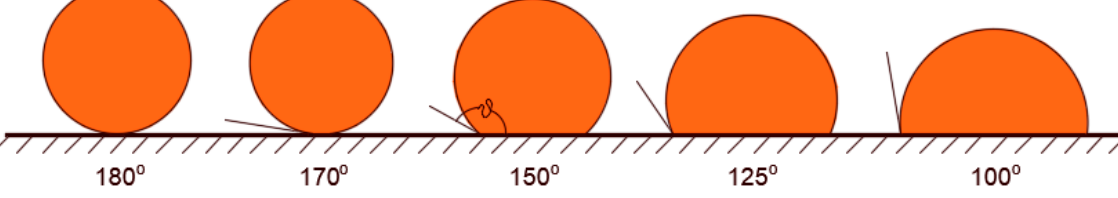
Figure 6. Succession of configurations of oil droplets at the surface of a membrane with different contact angles. When the contact angle is smaller, the droplet tends to spread over the surface more.